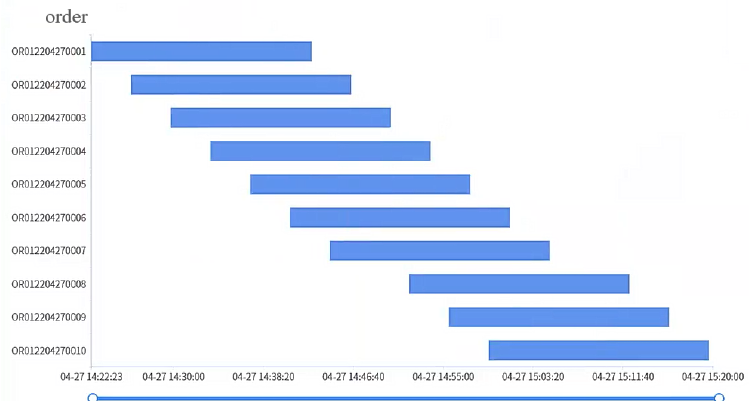
Figure 7. Order scheduling.